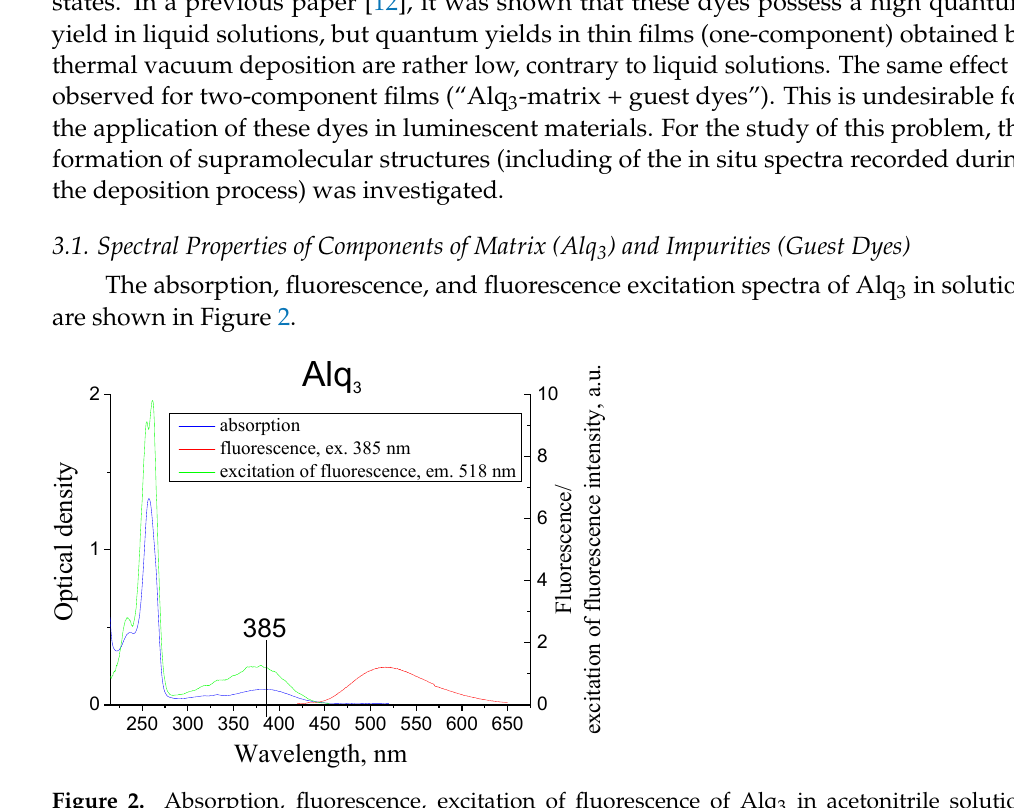
Figure 2. Absorption, fluorescence, excitation of fluorescence of Alq 3 in acetonitrile solution (C = − 6 g/cm 3 , T = 293 6.7×10 − 6 g/cm 3 , T = 293 K). (C = 6.7 × 10